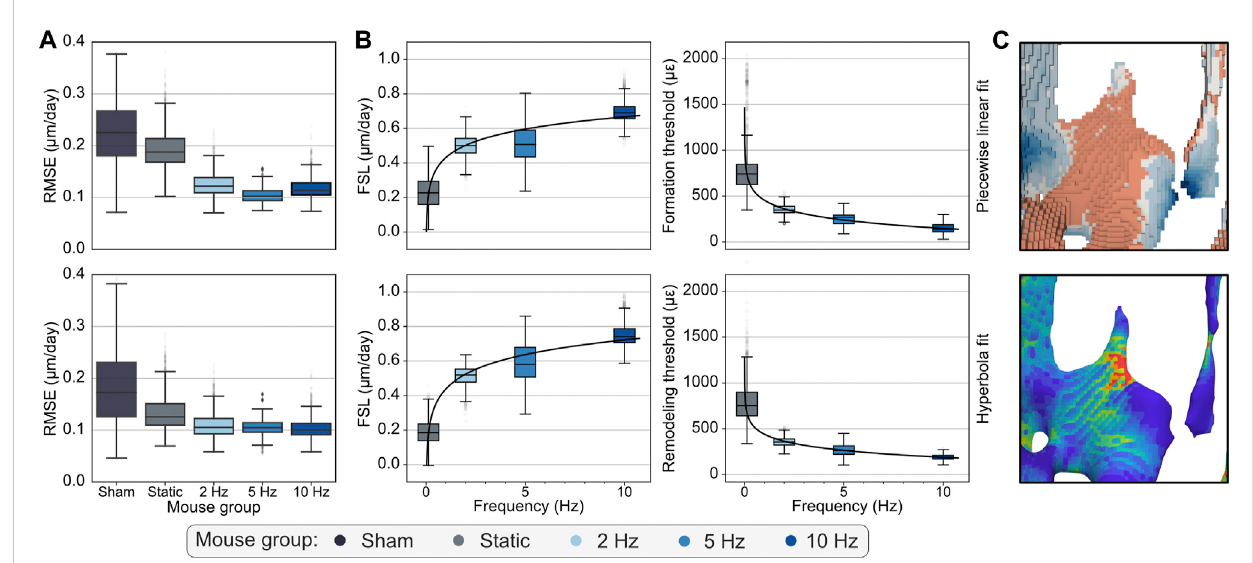
FIGURE 4 (A) Root mean squared errors (RMSE) associated with the piecewise linear (top row) and hyperbola (bottom row) fi tted functions for the analysis of weeks 1 – 2 are shown, highlighting that the hyperbola function consistently achieved lower errors than the piecewise linear function. (B) Logarithmic relationships fi tted to the bootstrapped distributions of mechanostat parameters estimated from the piecewise linear (top row) and hyperbola (bottom row) functions fi tted to the (re)modeling velocity curves for the weeks 1 – 2. Formation saturation levels (FSL), formation, and (re)modeling thresholds (FT and RmT) were among the parameters that followed a logarithmic trend throughout the 4 weeks of the study. (C) Qualitative visualization linking (re)modeling distance measurements with the mechanical environment determined from micro-FE analysis as